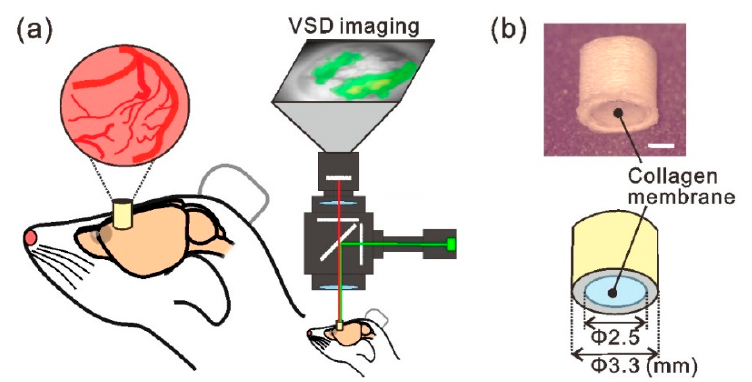
Figure 1. Experimental concept of the implantable cranial window for chronic voltage-sensitive dye (VSD) imaging. ( a ) Schematic view of the experimental setup. A cylinder-like device was attached to the skull and conventional VSD imaging [21] was performed by peering through it. ( b ) Upper image: photograph of the tube-shaped implantable-chamber device, wherein the bottom end of the tube was sealed with the atelocollagen membrane. The device was printed using a high-resolution three-dimensional printer. Lower image: design drawing of the device. Scale bar in ( b ), 1 mm.